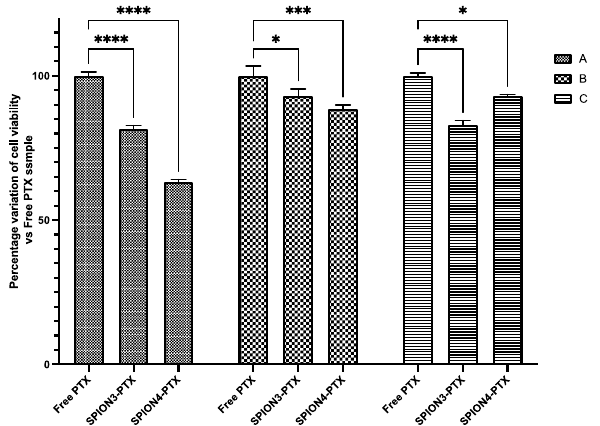
Figure 6. Percentage variations in 4T1 cell viability after incubation with nanoformulated PTX ver- sus free PTX at different concentrations (i.e., A, B, C respectively correspond to 6.25, 1.25, and 0.13 µg/mL of PTX). Note: **** p < 0.0001, *** p < 0.001, * p < 0.05 vs. free PTX sample at the same drug concentration (two-way ANOVA with Dunnett’s test).